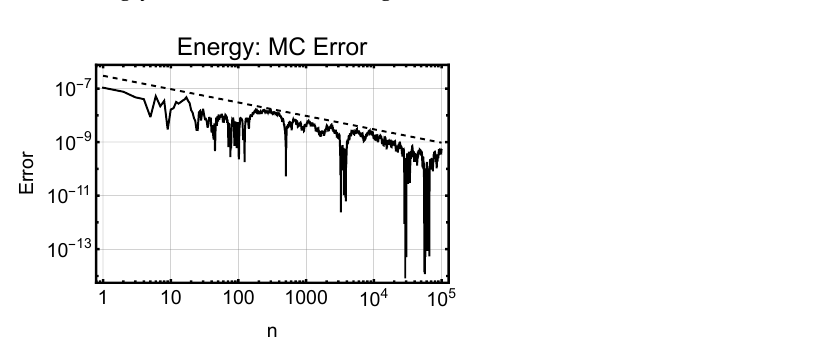
Figure 5. Monte Carlo error of the low-rank solution in energy. The dashed line is the expected √ n . The reference result is obtained with very high collocation rule. convergence rate ∼ 1/